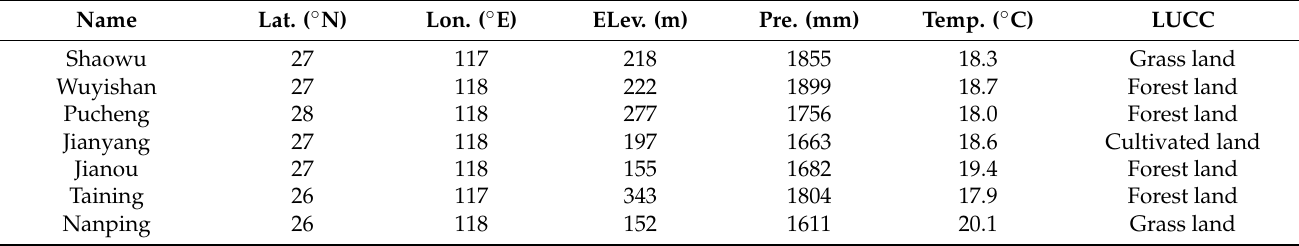
Table 1. Basic information of the eight meteorological